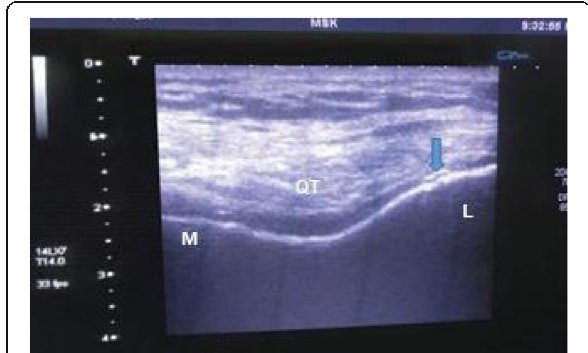
Fig. 3 MSUS; transverse scan shows thin hyperechoic band parallel to the surface of the hyaline cartilage (pattern I) in the femoral condyle characteristic of CPPD deposition. Knee, suprapatellar transverse scan in full flexion. Convex bony contour of femoral condyle is the deepest structure. A bright, hyperechoic band of CPPD deposition (arrow) is seen embedded in the dark, anechoic to hypoechoic hyaline cartilage that covers the femoral condyle. L,